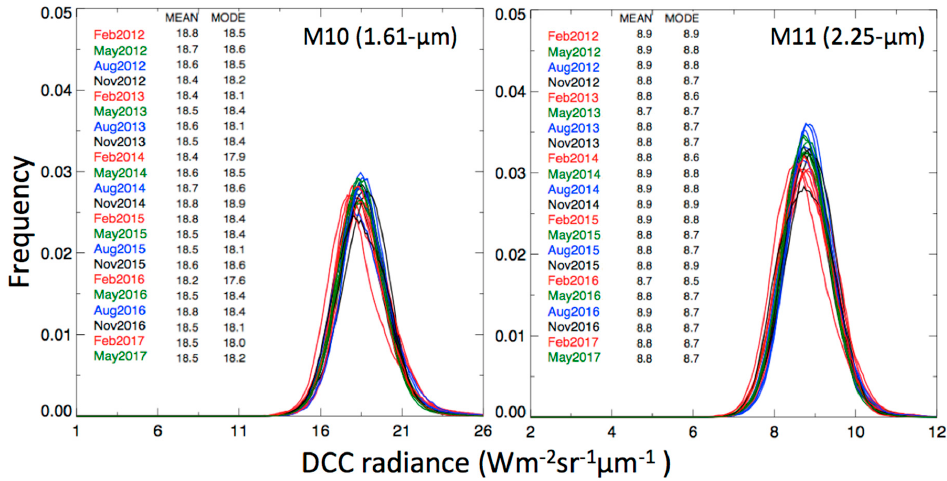
Figure 9. Monthly DCC PDF radiance plots for the VIIRS M10 and M11 bands after applying monthly BRDF corrections to individual DCC pixels. Compare to Figure 1.